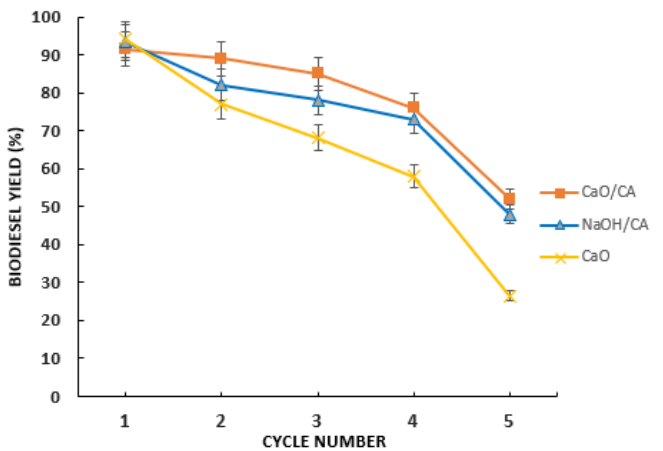
Figure 13. Biodiesel yield with different recycles of the catalyst in transesterification of BSFL